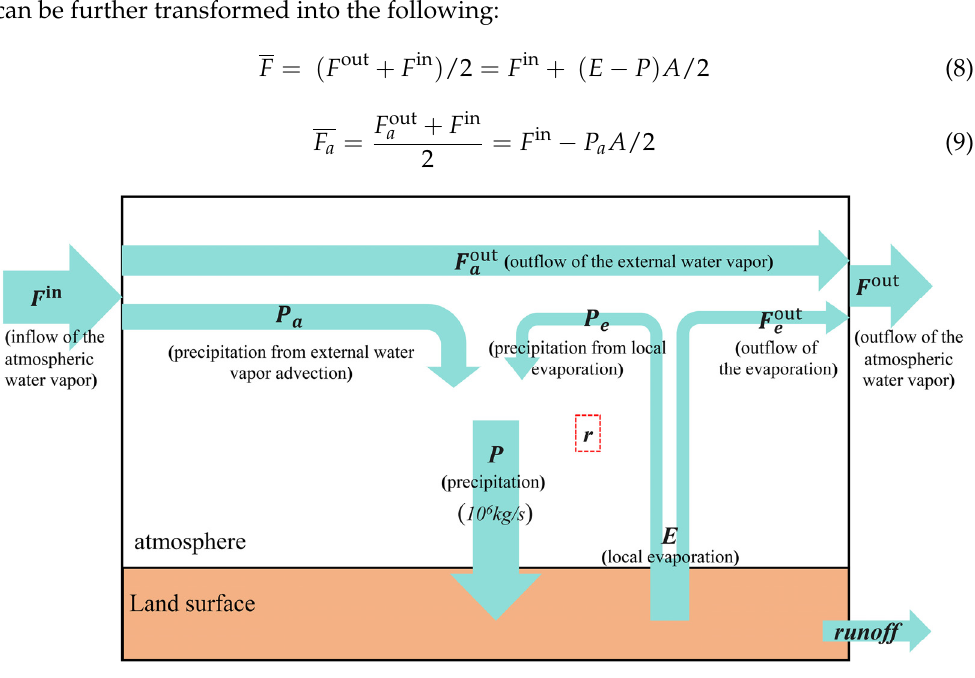
Figure 2. Atmospheric water cycle